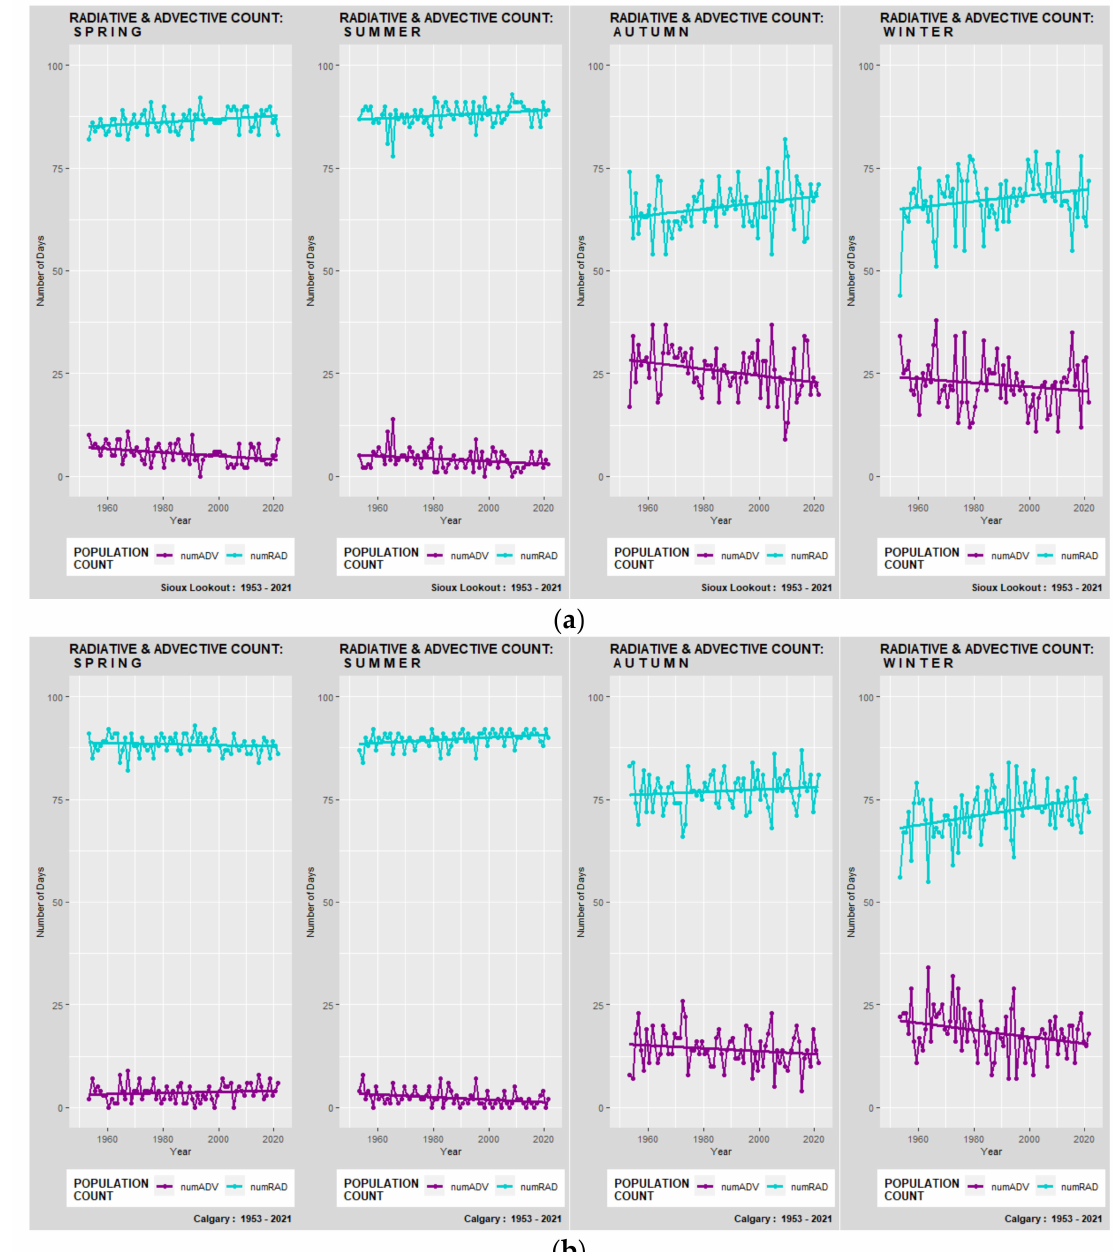
Figure 5. ( a )—Northeastern Forest (NEF); Sioux Lookout (ON), ( b )—Prairies (PRA); Calgary (AB). Seasonally averaged radiative and advective temperature population counts, listed in order of Spring, Summer, Autumn, and Winter. ( a )—Radiative Population Count ( RPC ) (cyan blue), and Advective Population Count ( APC )